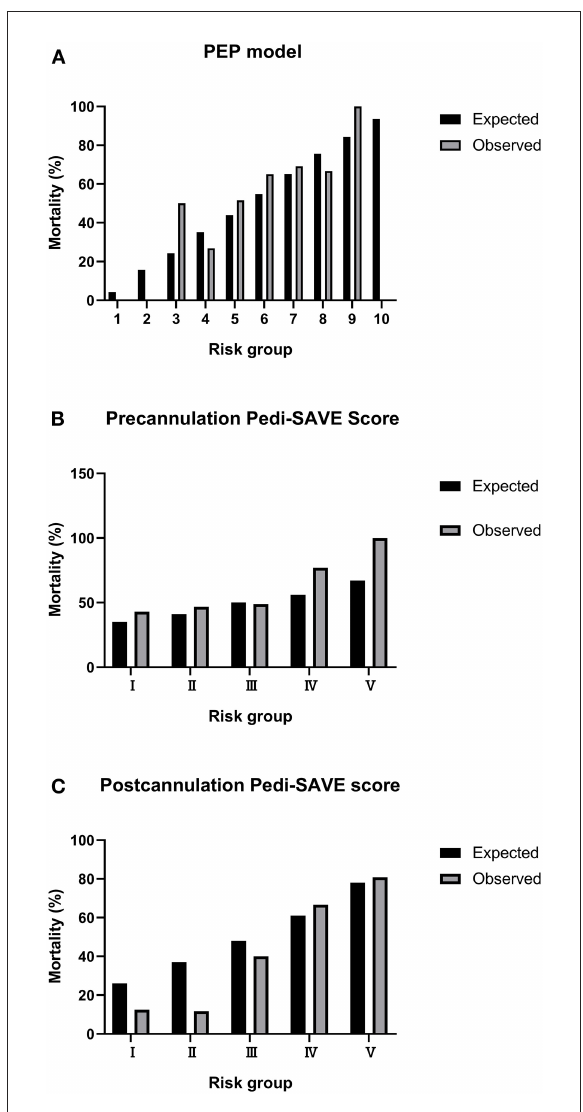
FIGURE1 Calibration plots for observed to expected mortality. PEP, Pediatric Extracorporeal Membrane Oxygenation Prediction; Pedi-SAVE, Pediatric Survival After Veno-arterial Extracorporeal Membrane Oxygenation. (A) PEP model. (B) Precannulation Pedi-SAVE score. (C) Postcannulation Pedi-SAVE score.